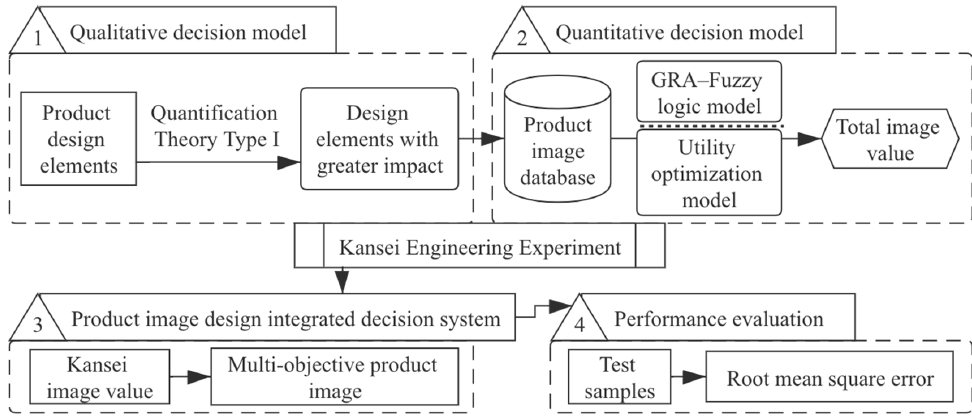
Figure 3. The four steps of the methodology process.